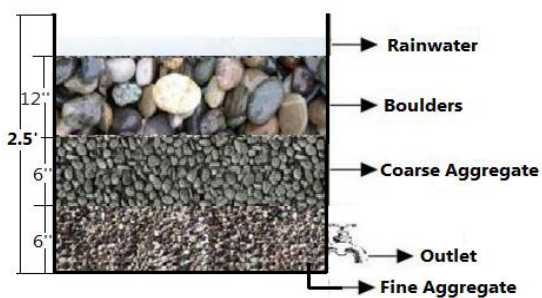
Figure 12. Filter media design for the recharge well infiltration mechanism.